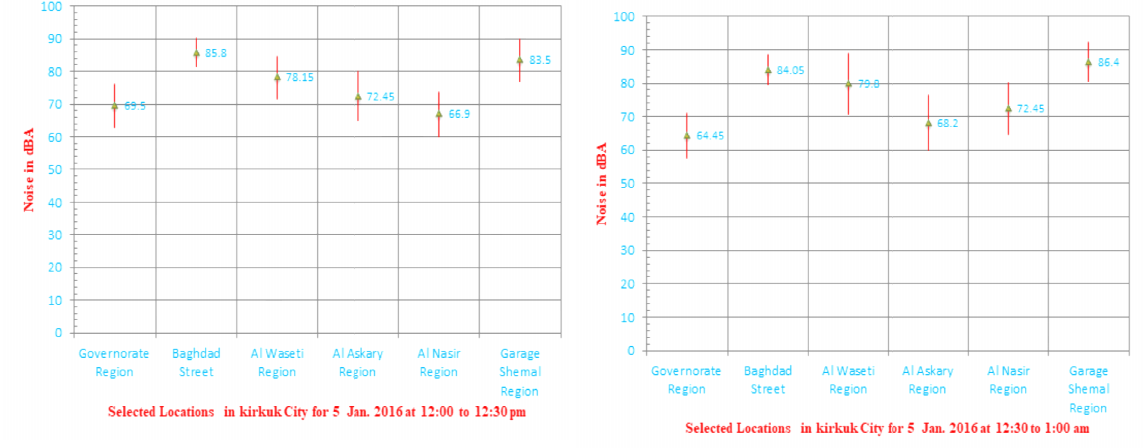
Fig. 14. Max, Min and Average Hourly Noise Max, Min and Average Hourly Noise Distribution for the traffic flow 5 Jan. 2015 Kirkuk City. Distribution for the traffic flow 5 Jan. 2015 Kirkuk City.